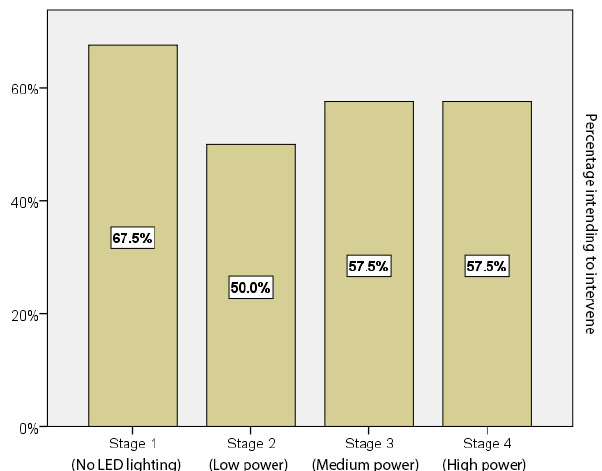
Figure 6. Percentage of participants indicating that they would turn on overhead lights or move the blinds down during each lighting condition.